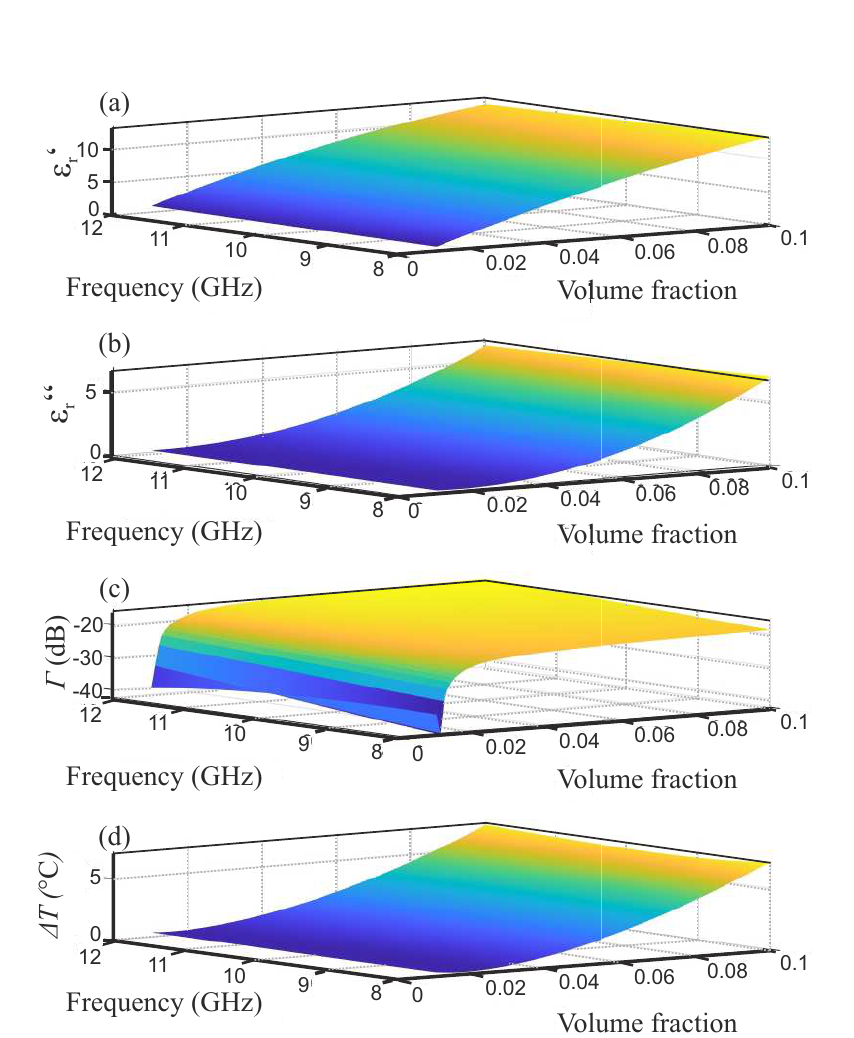
Figure 7. Resulting parameters of the fitted material mixing equation showing ( a ) real part permit- tivity, ( b ) imaginary permittivity, ( c ) total reflection coefficient, ( d ) maximum heating. Subfigures ( c , d ) apply for the above described indicator material and measurement